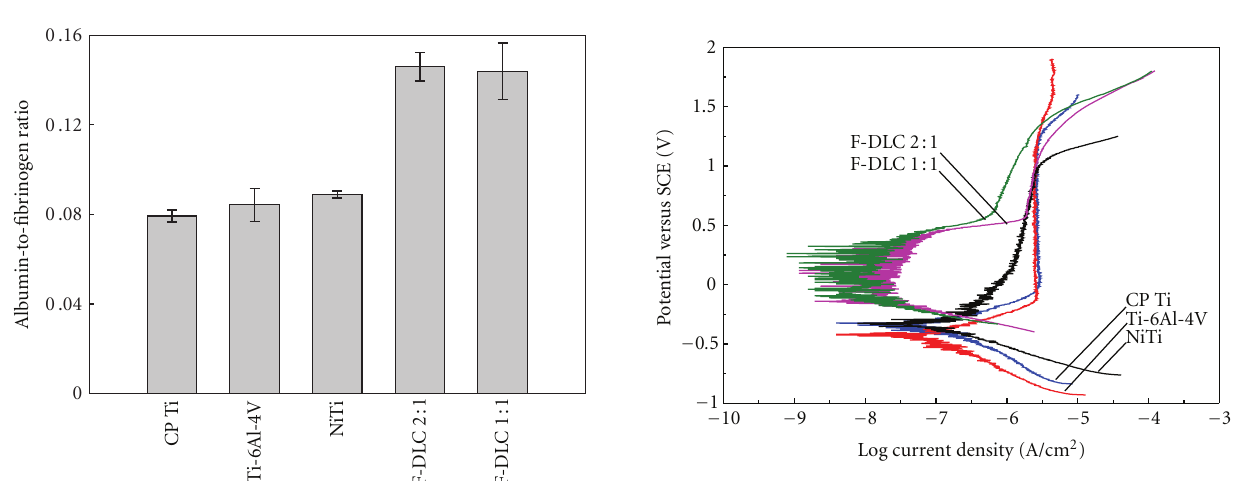
Figure 5: The potentiodynamic polarization curves of Ti alloys and F-DLC films.